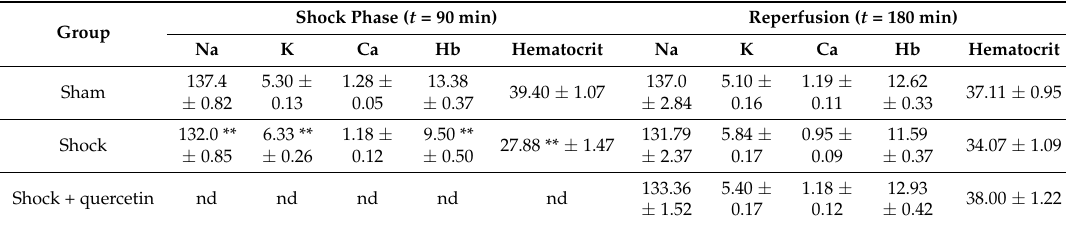
Table 1. Electrolytes, hematocrit and hemoglobin (Hb).